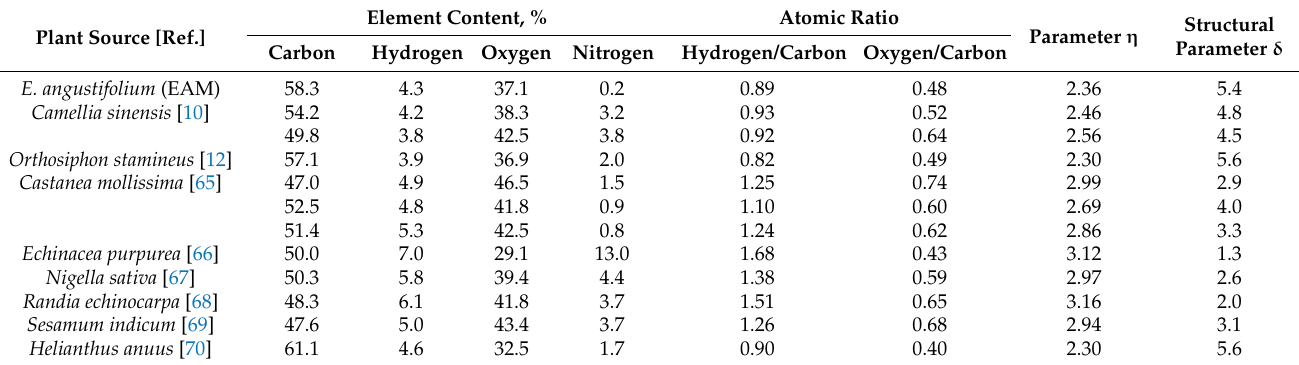
Table 3. The elemental composition of E. angustifolium melanoidin (EAM) and selected known plant melanoidins. Plant Source